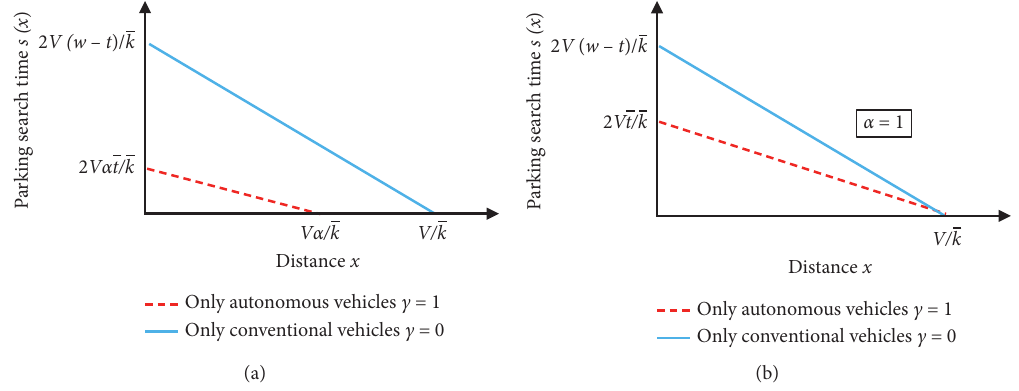
Figure 8: (a) Parking search cost with a general α and (b) parking search cost with α �